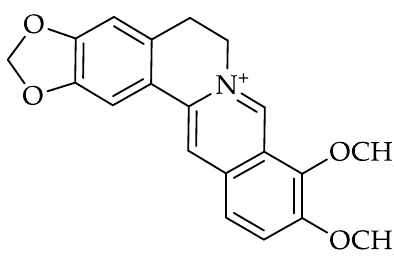
Figure 1. Molecular structure of berberine.